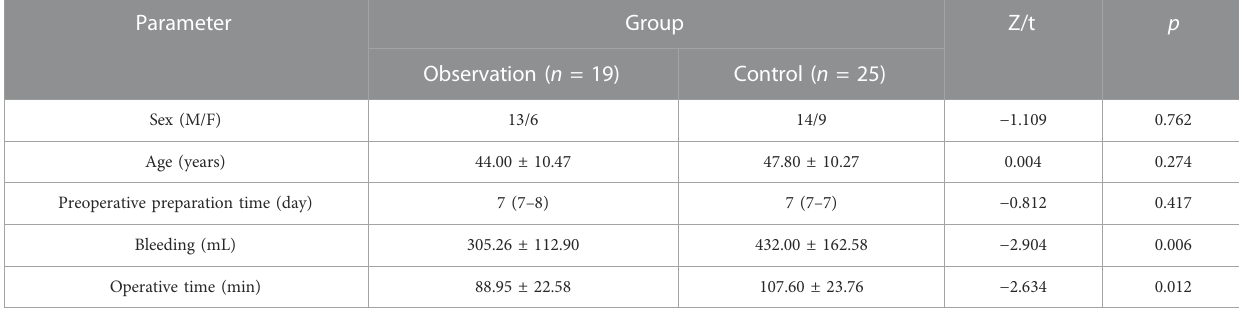
TABLE 2 Intergroup comparison of patients ’ conditions at baseline and immediately after surgery.